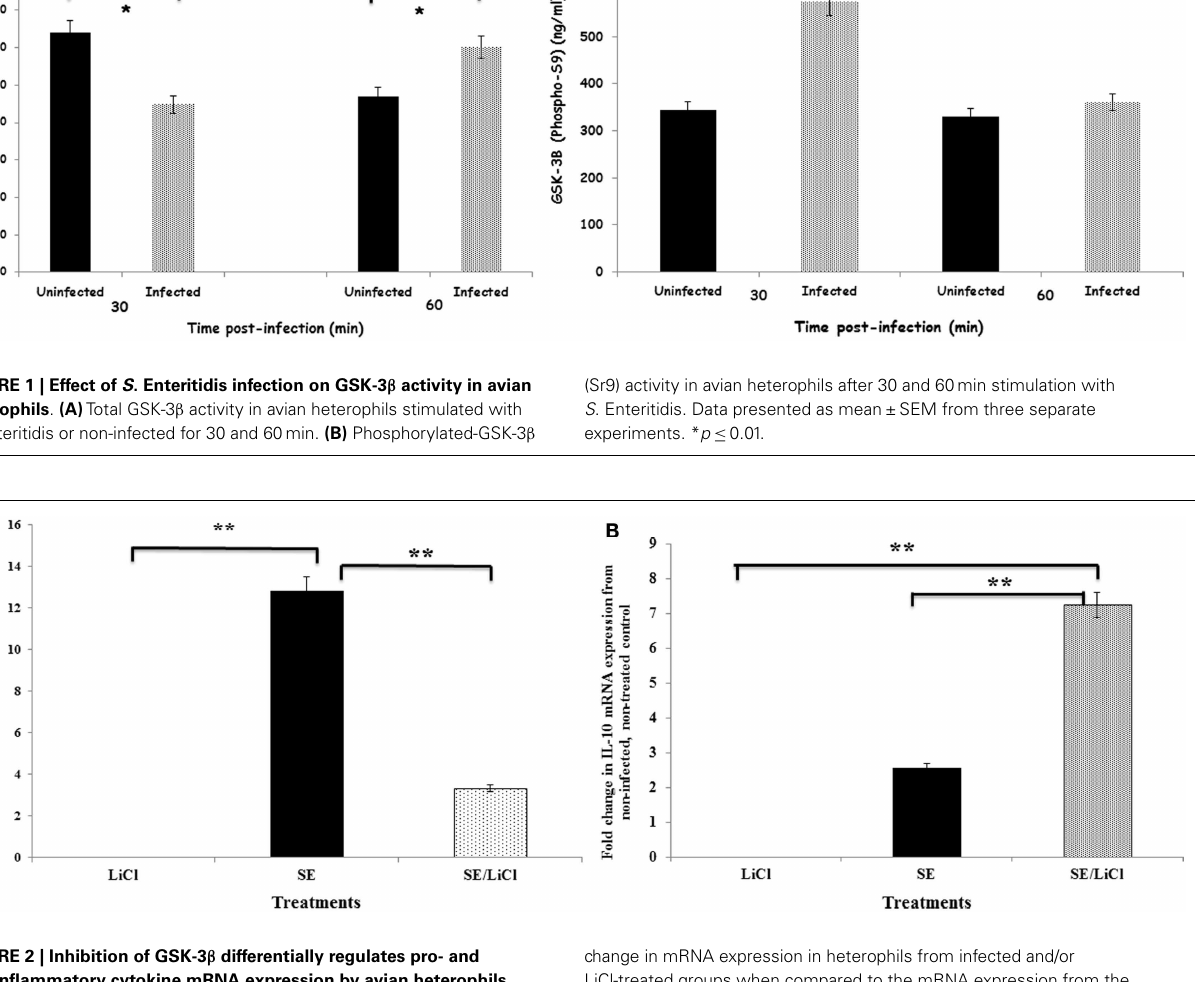
FIGURE 2 | Inhibition of GSK-3 β differentially regulates pro- and anti-inflammatory cytokine mRNA expression by avian heterophils . Heterophils were pre-incubated with LiCl for 1h and then stimulated with S . Enteritidis (MOI = 100) for 30 and 60min.The expression of cytokine mRNA was determined by quantitative RT-PCR. Data represent the fold